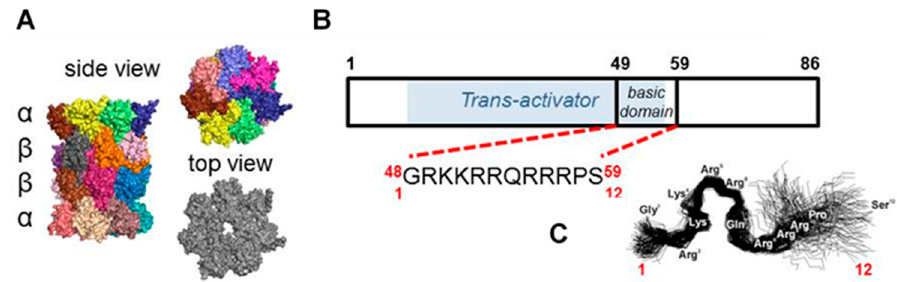
Figure 1. The human 20S core proteasome, Human Immunodeficiency Virus-1 (HIV-1) Transcriptional Activator TAR (Tat) protein and TAT1 peptide. ( A ) The crystal structure based model of the 20S catalytic core proteasome. Colored subunits of the tube-shaped core are arranged in four heptameric rings ( αββα ) that form the inner catalytic chamber and the outer “ α face” equipped with a central gate for substrate uptake and product release. The pockets between α subunits are utilized to anchor 19S or other regulatory modules of the catalytic core. Based on Protein Data Bank structure pdb 5t0g [25]. ( B ) Scheme of HIV-1 Tat protein, with the domain required for transactivation [26,27] shaded blue and with the short fragment designated as TAT1 marked. ( C ) Our previously reported molecular dynamics simulation of TAT1, suggesting a potential for formation of two turns (modified from [22,24].